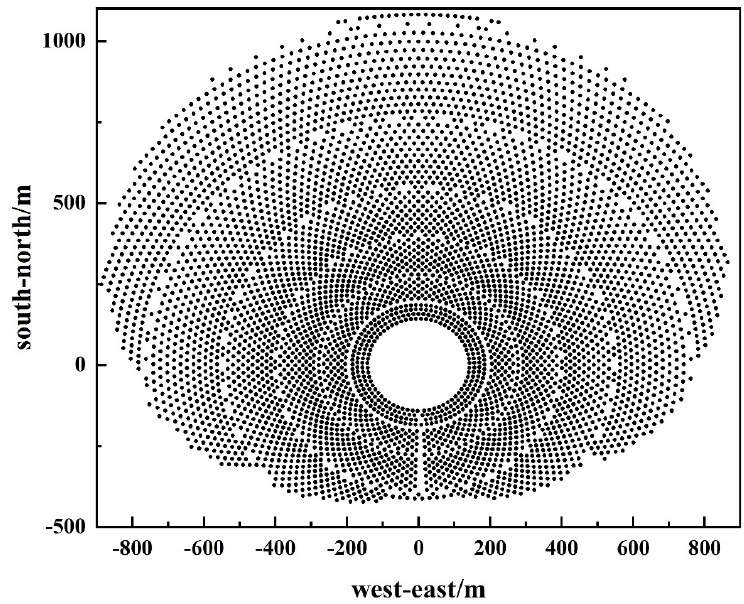
Figure 2. The layout of the heliostat field.